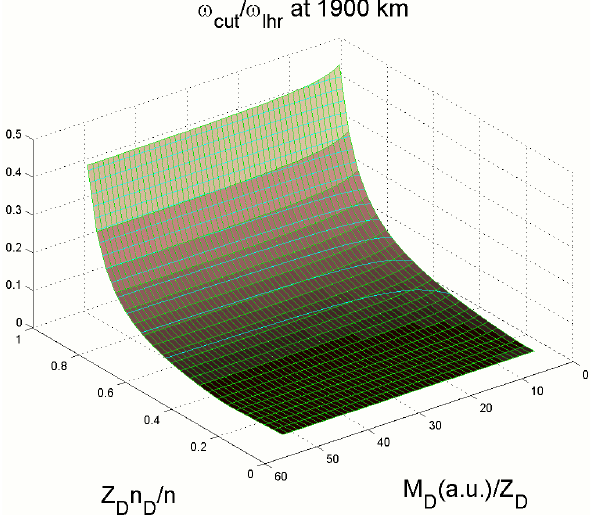
Fig. 3. The 2-D profile of the ratio of the highest ion cut- off frequency to the LHR frequency as a function of the rela- tive negative ion charge content Z D n D /n and the inverse specific charge of negative ion M D (a.u.)/Z D = (M D /M)/Z D (in the inter- val M D (a.u.)/Z D > 4) for plasma parameters corresponding to the altitude h ’